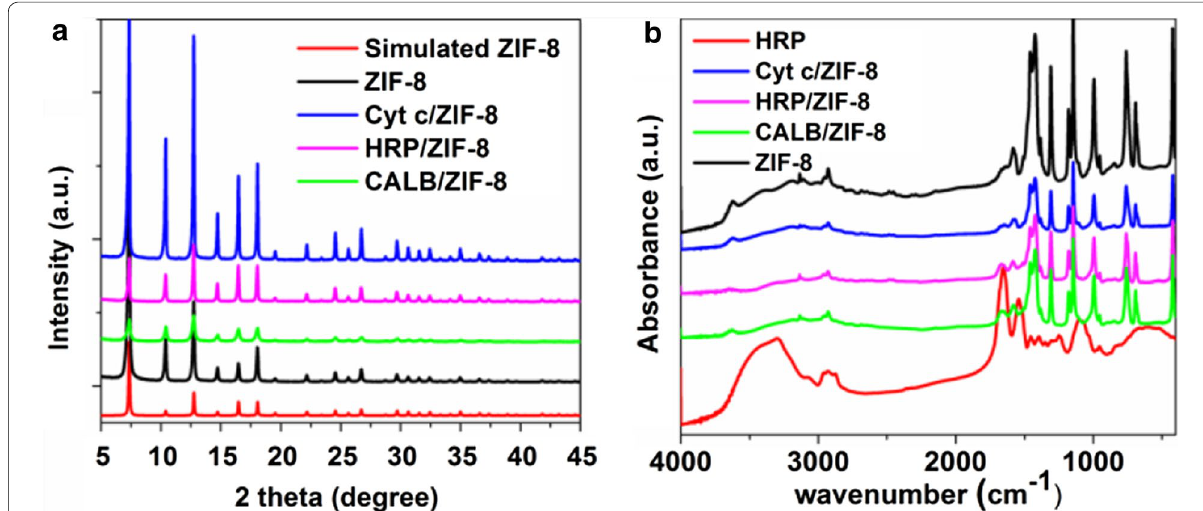
Fig. 3 a XRD patterns of ZIF-8, Cyt c/ZIF-8, HRP/ZIF-8, CALB/ZIF-8, and simulated ZIF-8. b FT-IR spectrum of ZIF-8, Cyt c/ZIF-8, HRP/ZIF-8, CALB/ZIF- 8, and